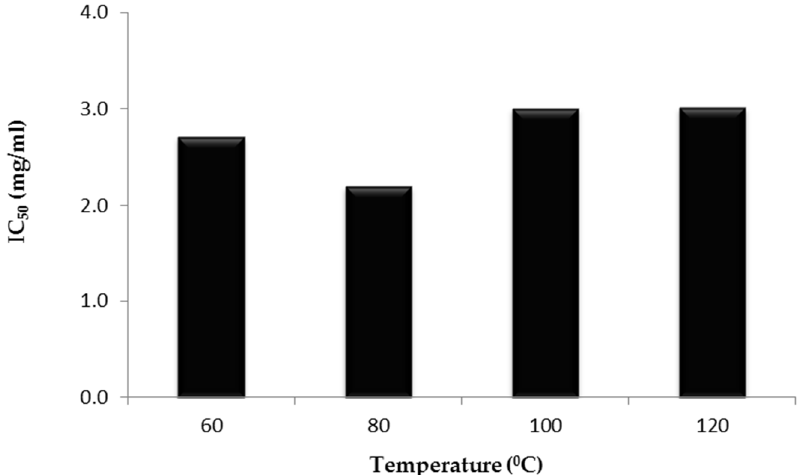
Figure 3. IC 50 values for DPPH radical scavenging activity of Roselle dried at different temperatures.